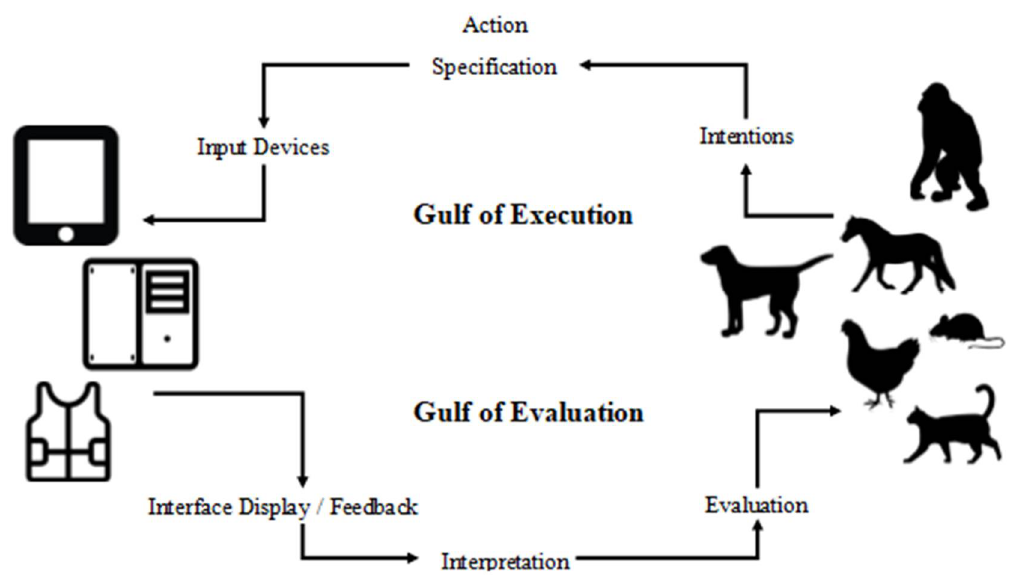
Figure 1. Representation of the gulf of execution in ACI systems.